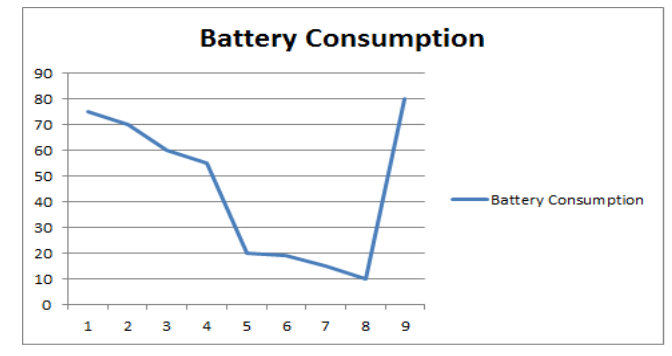
Figure 8. Battery